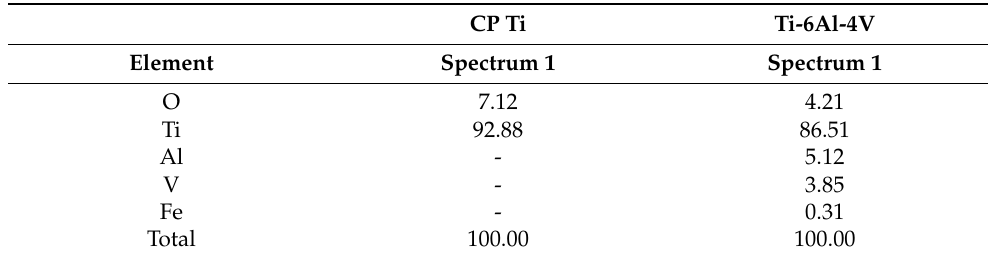
Figure 4. SEM image of ( a ) CP Ti and ( b ) Ti-6Al-4V alloy after potentiodynamic polarization measurements in PBS solution with marked surface of EDS analysis. Table 3. Elemental composition on marked surface on surface CP Ti and Ti-6Al-4V alloy after potentiodynamic polarization measurements in PBS solution.